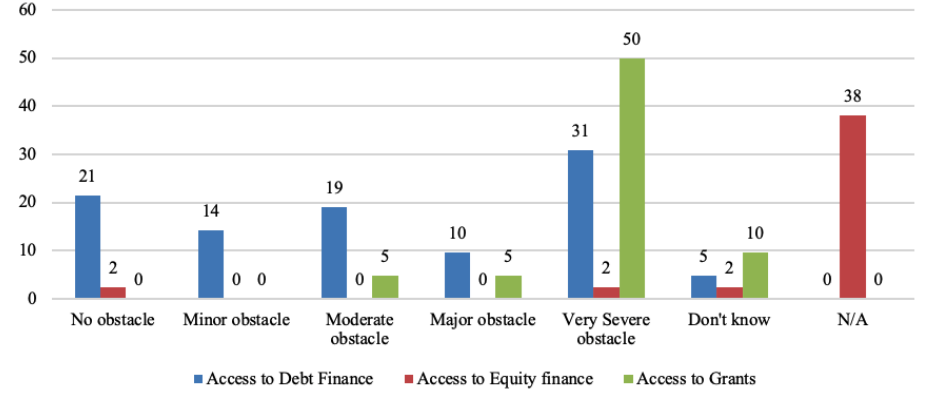
Figure 2: Elements of finance